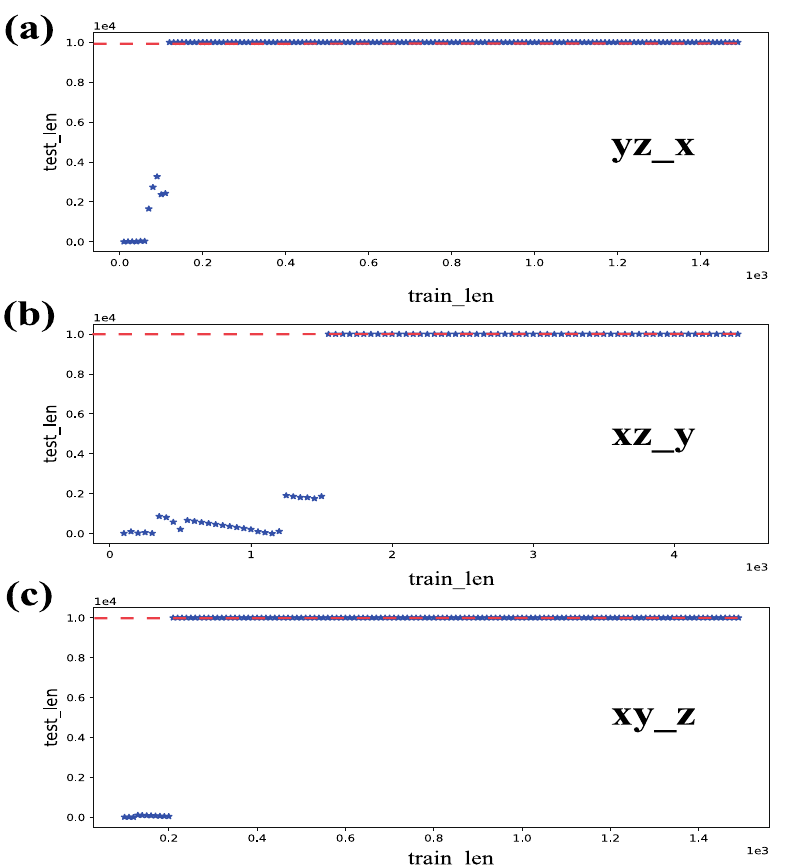
Figure 4. ( a – c ) Tendency of the longest T test of variable x , y , z versus T train in each mode, when the RMSE of the Lorenz system < 0.1 . The Max( T test ) has been set at 10 4 . The blue star dots are the longest reconstructable